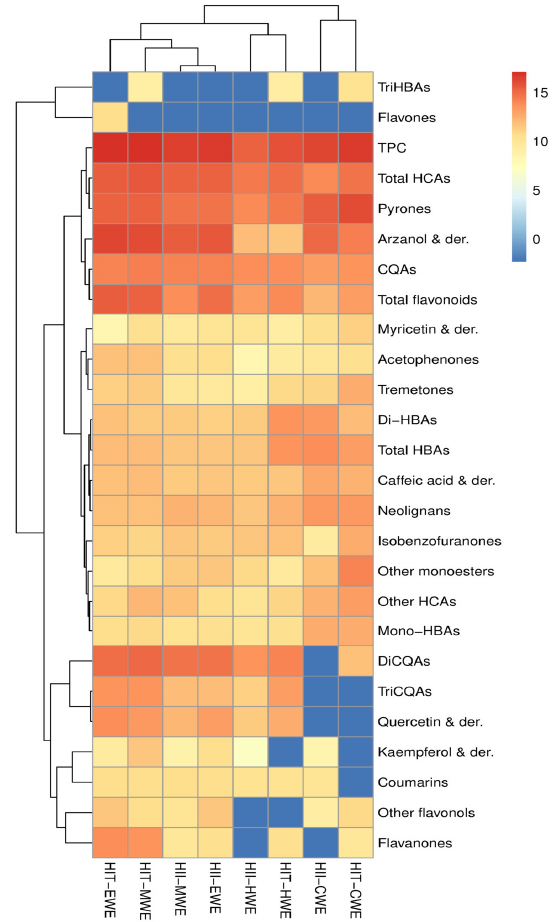
Figure 2. Heatmap representing the results of semi-quantitative analysis of putatively identified compounds in H. italicum extracts. Calculations were performed based on areas of extracted ion chromatograms (EICs), corrected for dilution factor during sample preparation. The abscissa is used to display the names of samples and the ordinate on the right is used to display the names of metabolites. The deeper the red color, the higher the content of the metabolites; the deeper the blue color, the lower the content of the metabolites. CQA—caffeoylquinic acids, HCA—hydroxycinnamic acids, HBA—hydroxybenzoic acids, TPC—total phenolic content (sum of all the identified and quantified compounds),